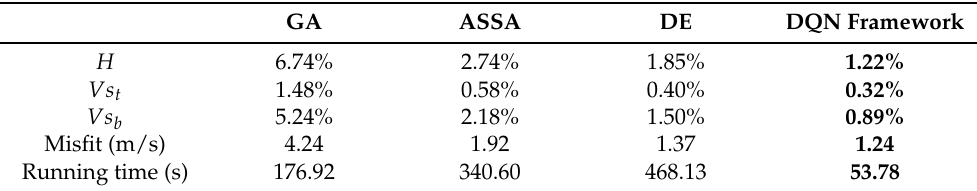
Figure 8. The estimated shear wave velocity profiles with the ground truth in Case 2. Table 8. Performance analysis for Case 2.